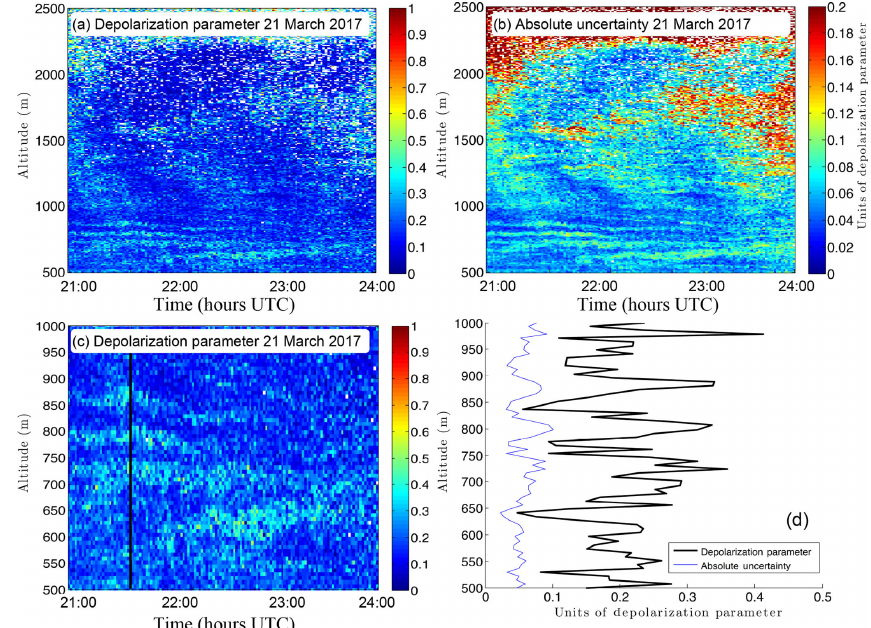
Figure A1. 21 March 2017. Panel (a) is the depolarization parameter from 500 to 2500m on a colour scale between 0 and 1. Panel (b) is the corresponding absolute uncertainty in units of depolarization parameter on a colour scale between 0 and 0.2. (c) is an enlarged portion of panel (a) . The black vertical line indicates the profile plotted in (d) . Panel (d) shows a single 1min profile of depolarization parameter in black, and its corresponding absolute uncertainty profile in blue.